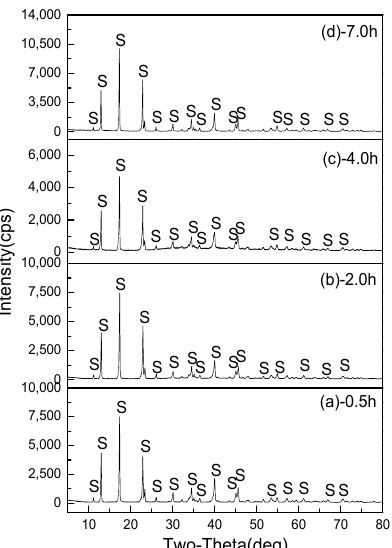
Figure 14. XRD patterns of whiskers obtained at different hydrothermal periods of time S-5Mg(OH) 2 ·MgSO 4 ·2H 2 O.